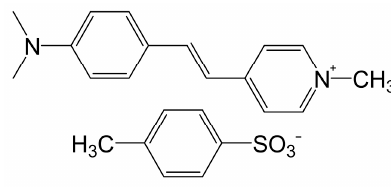
Figure 1. Chemical structure of DAST.